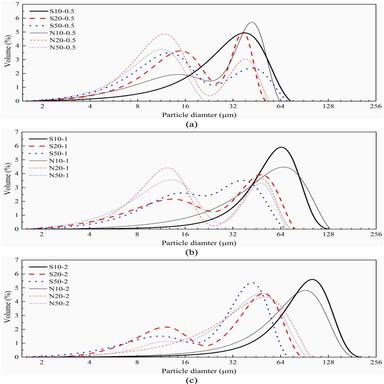
Volume weighted particle size distributions of CNT suspensions of different CNT geometries: (a) 0.5%; (b) 1%; (c) 2% CNT fractions.